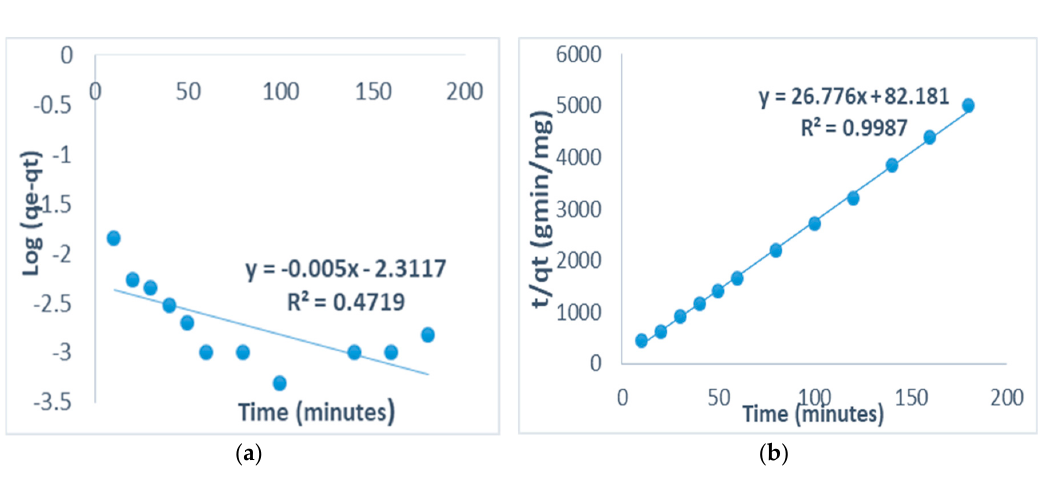
Figure 10. ( a ) Pseudo-first order and ( b ) Pseudo-second order model of fluoride adsorption onto the activated clay.